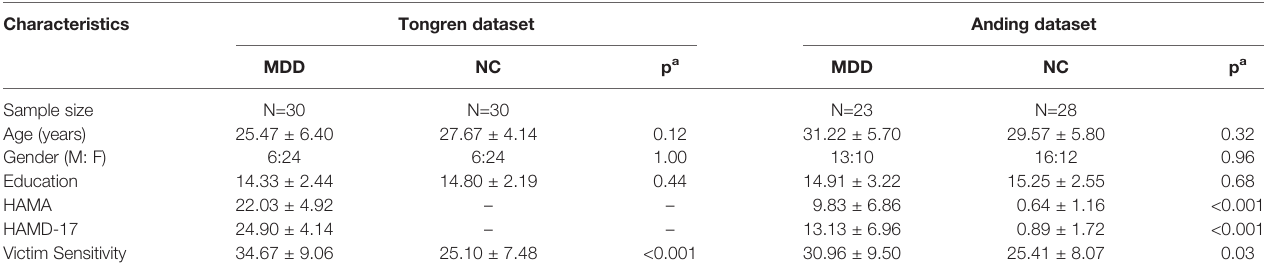
TABLE 1 | Demographics and clinical information of patients with MDD and healthy controls within the two datasets.